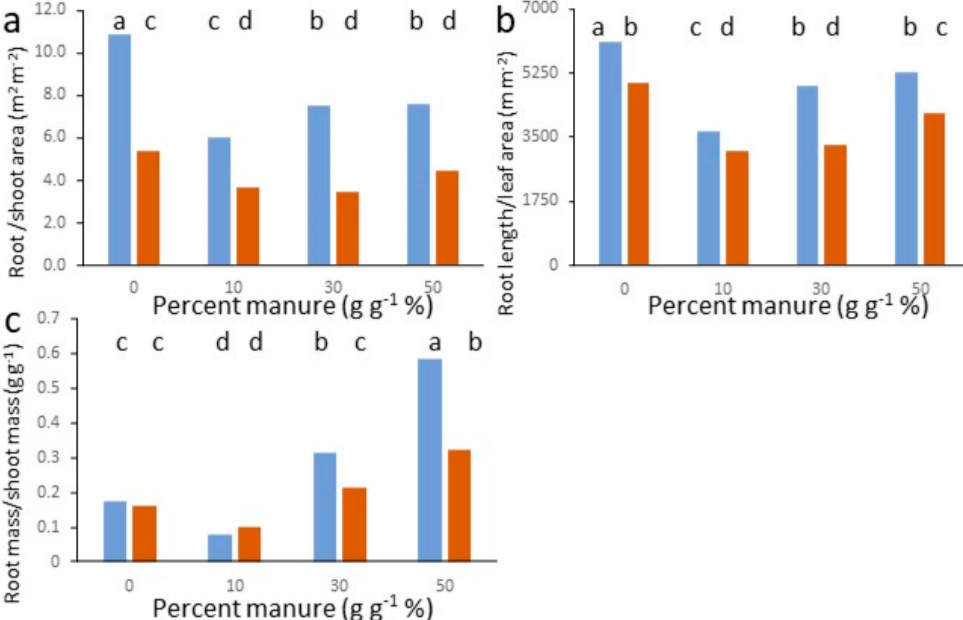
Figure 2. Interaction of simulant and manure concentration on allometric relations; ( a ) root-to-shoot mass ratio; ( b ) root-to-leaf surface area; and ( c ) root length per unit leaf area. Orange bars: MMS1; blue bars: LHS1. Bars with different letters are different for p < 0.05 at the post hoc Duncan’s mean separation test.